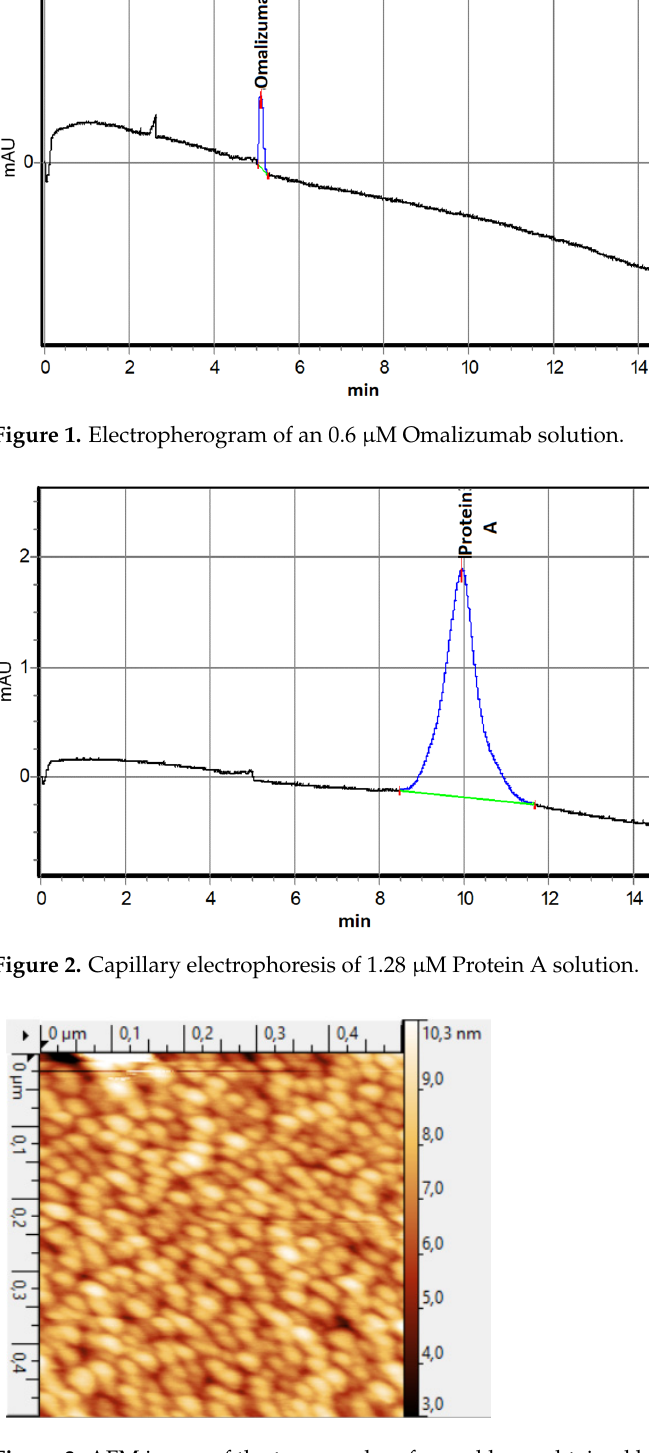
Figure 3. AFM image of the topography of a seed layer obtained by ultrasonic spray pyrolysis.